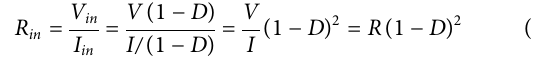
FIGURE 3 | Circuit schematics showing PV cells and the DC/DC power interface.